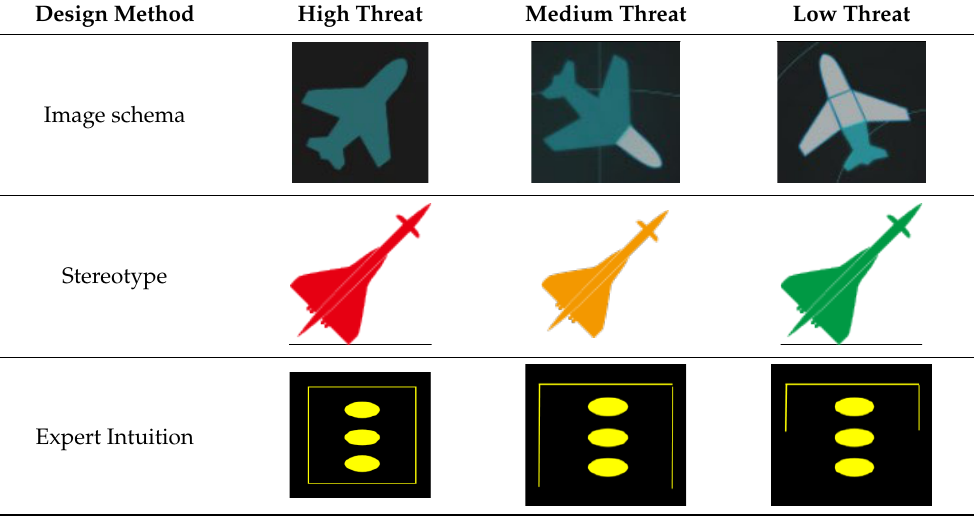
Table 4. Example of threat level display design.